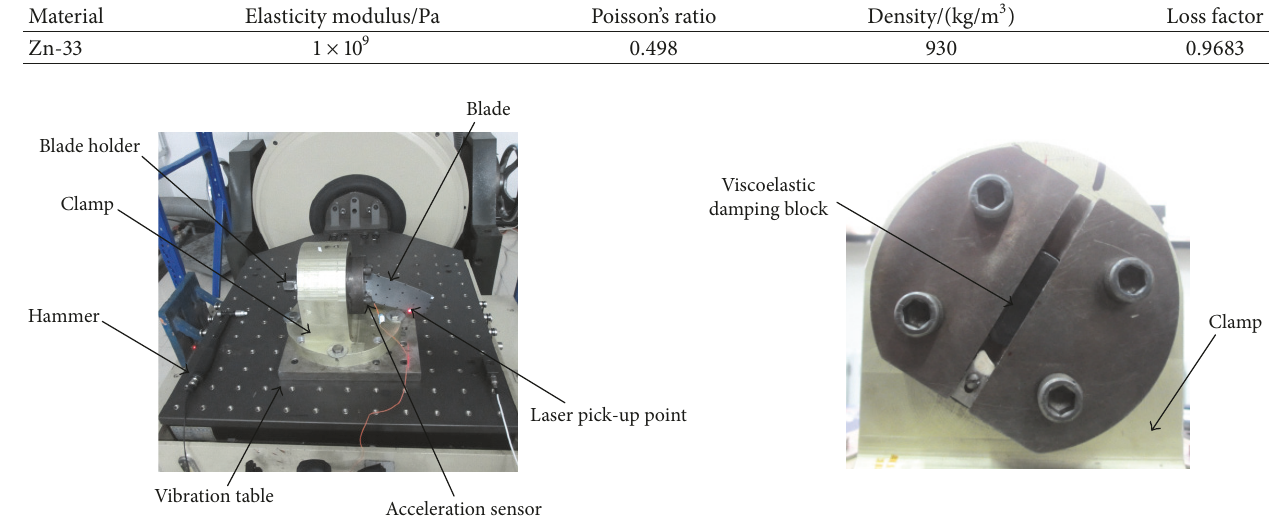
Figure 4: Test device of VE-blade.